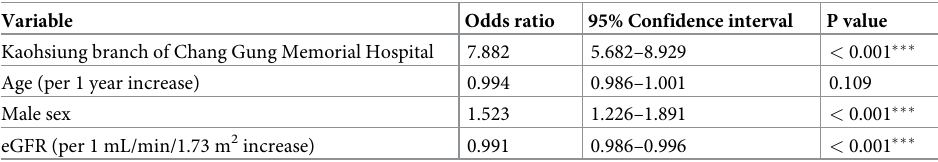
Table 2. Multivariable logistic regression analysis for risk factors associated with BLL > 5 μ g/dL (n = 3804).